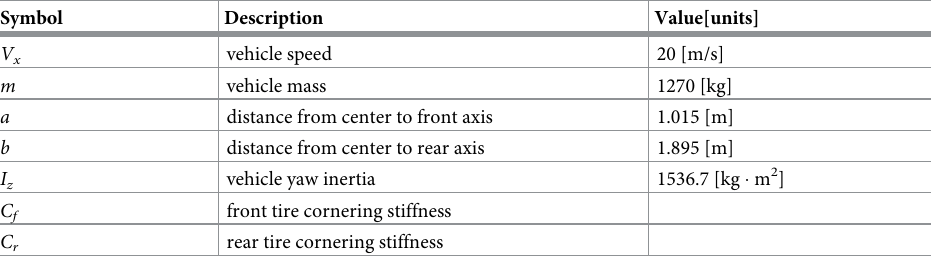
Table 1. Parameters of vehicle model for path-following